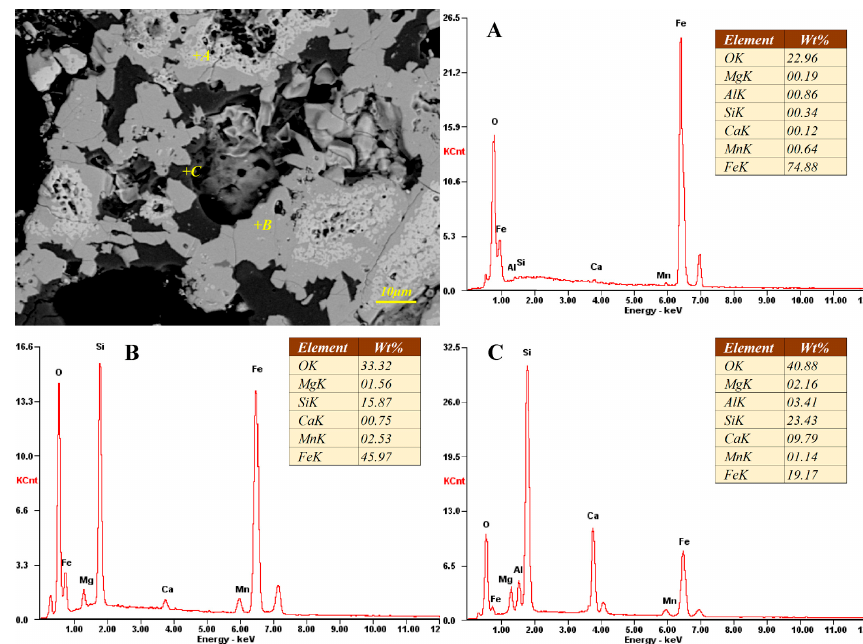
Figure 6. Scanning electron microscopy (SEM)-energy dispersive spectra (EDS) analysis of external deposit sample (S1).